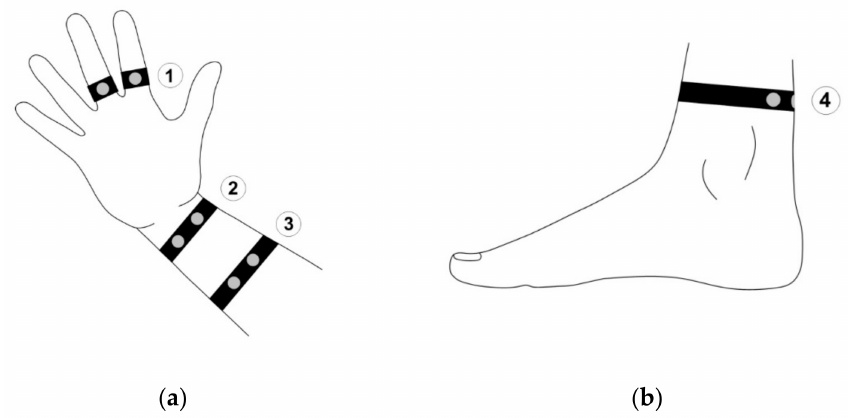
Figure 5. Placement of the sensors: ( a ) On the arm, ( b ) on the leg; 1—index and middle fingers (reference point), 2—wrist, 3—forearm, and 4—ankle.